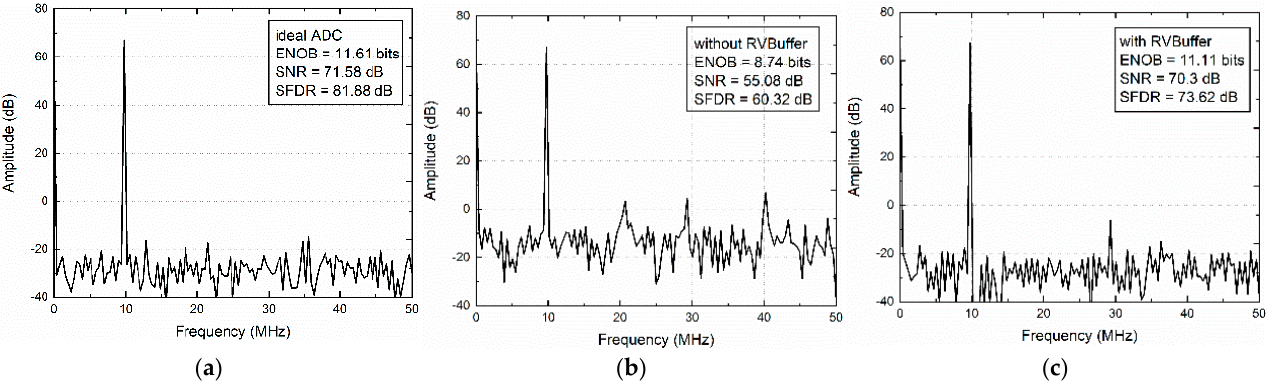
Figure 10. The simulated spectrum: ( a ) under the ideal situation; ( b ) with parasitic inductance and without RV-Buffer; ( c ) with parasitic inductance and with RV-Buffer.